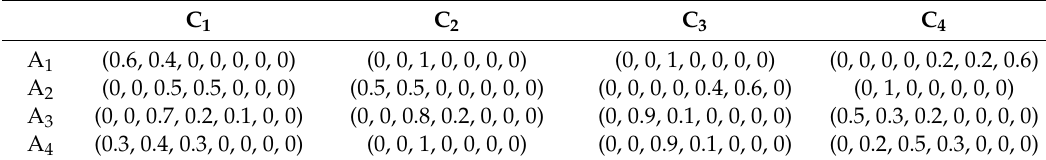
Table 5. Possibility distribution hesitant fuzzy linguistic decision matrix by expert E 2 .